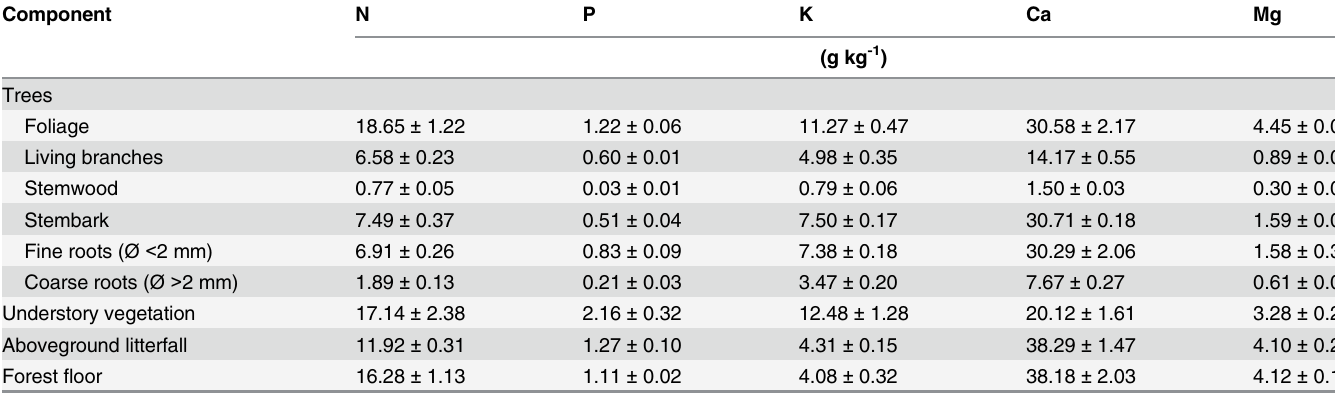
Table 2. Concentrations of selected nutrients in different components of the 10-year-old P . deltoides plantation